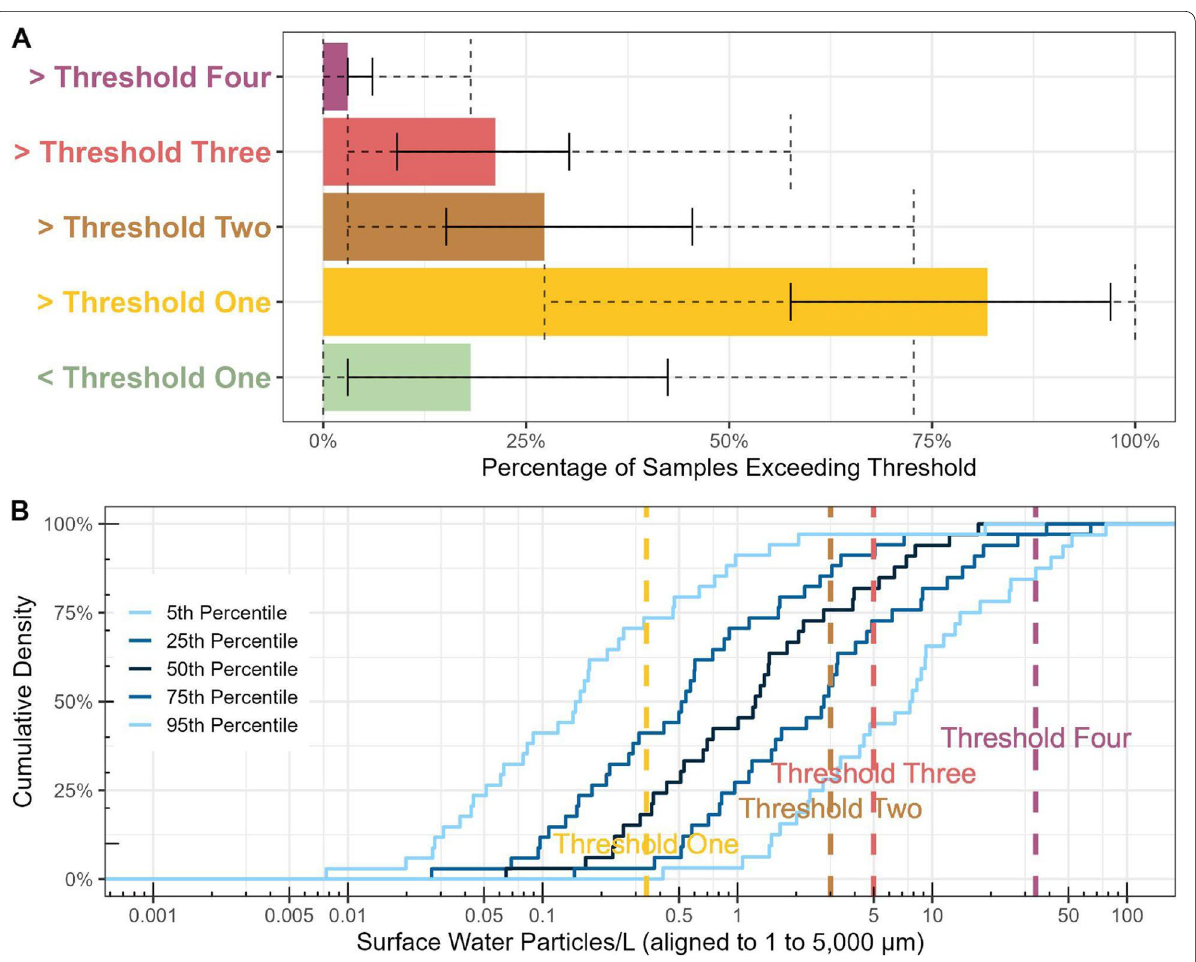
Fig. 3 Comparison of corrected and rescaled surface water concentrations of microplastics in SFB collected using manta trawl with food-dilution threshold derived by Mehinto et al. [42]. A percentages of samples exceeding each threshold are shown as bar plots, with solid-line error bars reflecting the 25th and 75th percentiles and dashed-line error bars reflecting the 95th percentile confidence intervals derived using Monte Carlo simulations ( n 10,000) based on probability density functions derived from the combined variability of correction factors and rescaling. B = Empirical cumulative density plot of surface water concentrations and 25th and 95th percentile confidence intervals of correction factors compared to food dilution thresholds. Exceedances are only considered statistically significant when the 95% confidence interval does not include